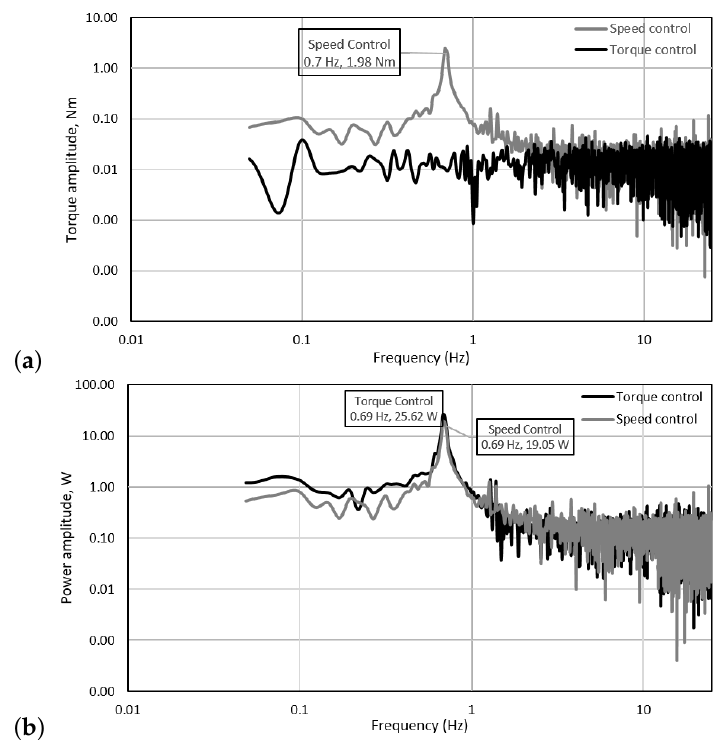
Figure 15. Frequency domain graphs for a regular wave-tow test at peak power condition of TSR = 3.6, i.e., 76 rpm, 15 Nm for rotor: ( a ) torque and ( b )